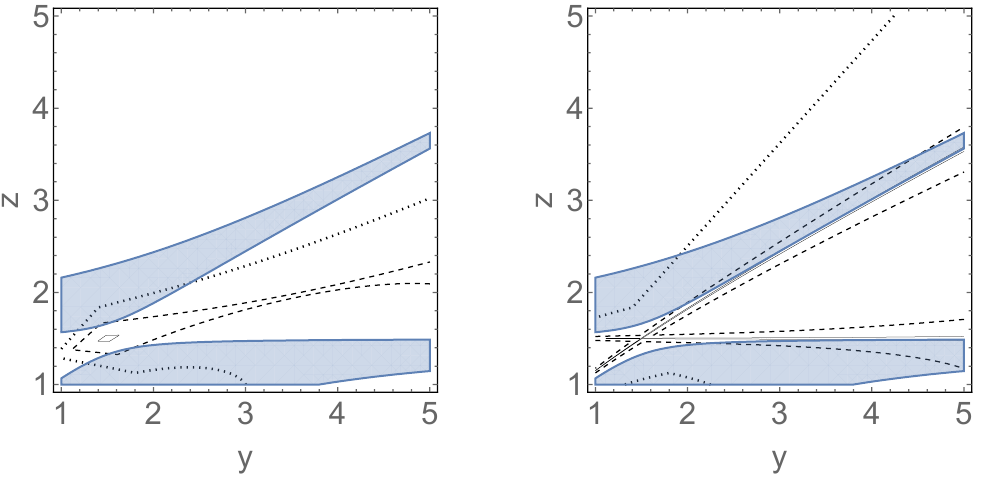
Figure 1 . In the left and right panels, we plot two ratios r 1 and r 2 of eigenvalues of the physical Yukawa couplings ( Y ) to the maximum one at the fixed x = 1 . 5 , respectively. The dotted, dashed, ˆ3ˆ a ˆ b and solid curves correspond to the values for 10 − 1 ( 10 − 1 ), 0 . 05 (10 − 2 ) , and 10 − 2 (10 − 3 ) , in the left (right) panel. In both panels, blue shaded regions represent the allowed volume 1 < V ≤ 30 . Note that the Yukawa matrix reduces to the rank-two Yukawa matrix at z = y + the vicinity of the solid